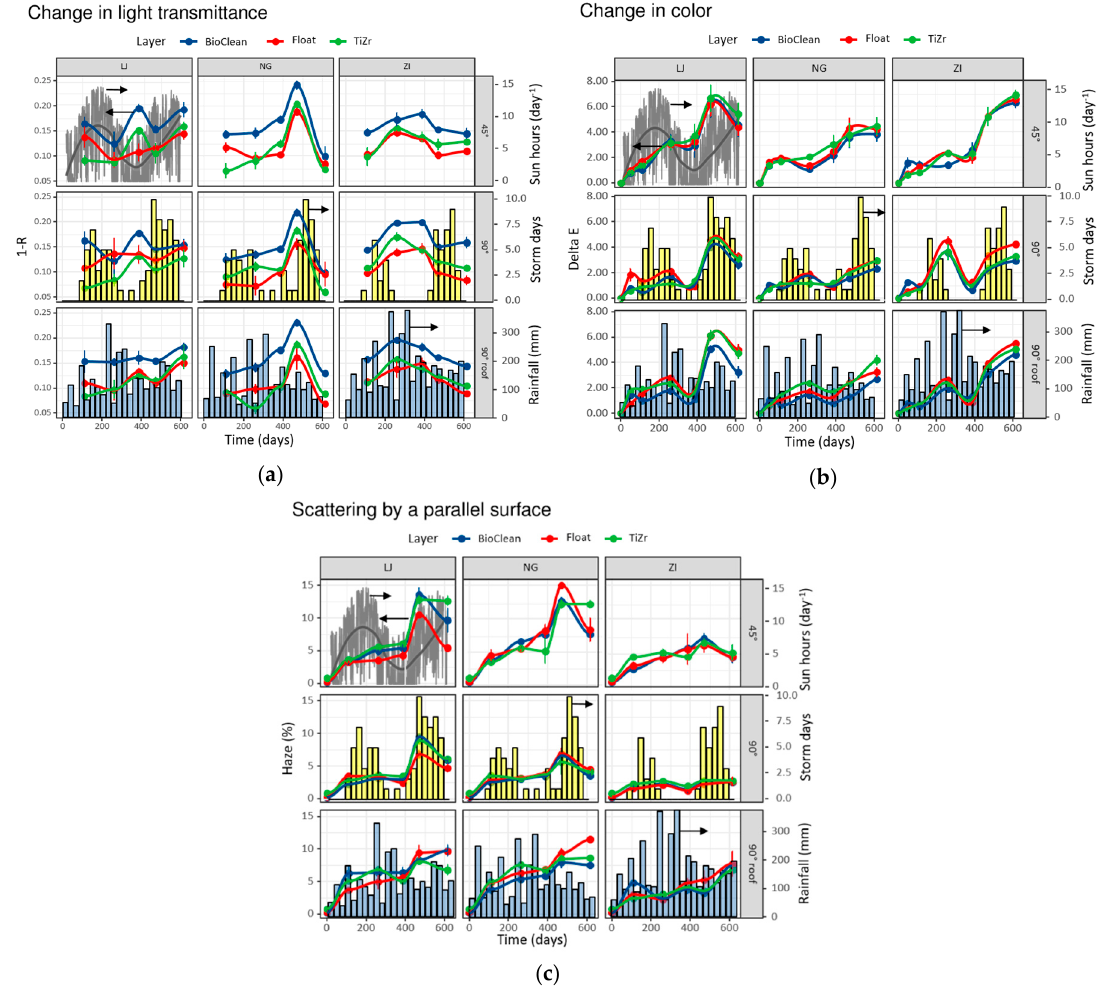
Figure 3. Results of field testing of the surfaces; change in light transmittance is expressed as change in transmittance (1-R) according to lux meter ( a ), color changes ( ∆ E*) ( b ), and changes in haze ( c ). The blue and yellow columns represent the average monthly rainfall and the number of days with storms in one month on the three locations, respectively, and are valid for all panels. The gray lines in the top-left panel represent the number of hours of sun per day and are valid for this location only (Ljubljana). Results are faceted by areas (vertical facets) and angles of exposure (horizontal facets).